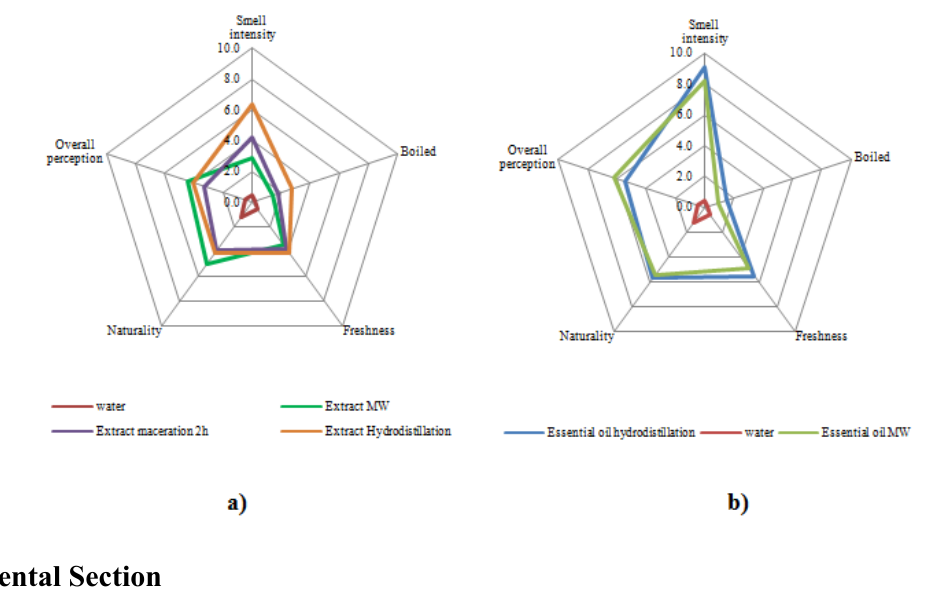
Figure 5. Sensorial analysis of: ( a ) aqueous extracts and ( b ) essential oils.